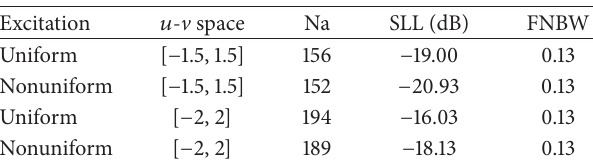
Table 2: Results of thinned CCAA optimized by MTLBO for SLL reduction in the extended 𝑢 - V